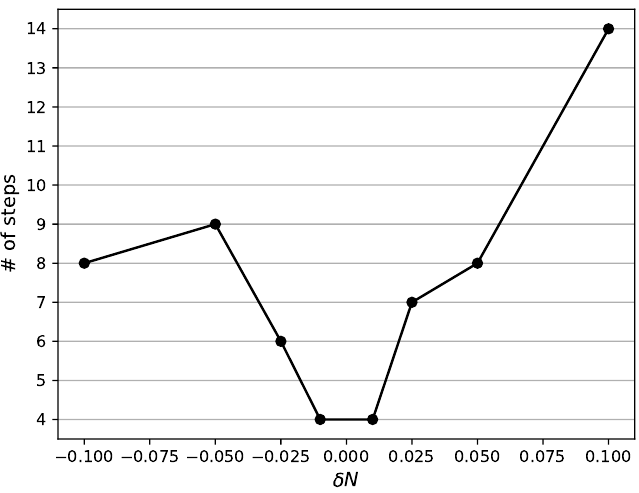
Figure 3: Number of function calls until BFGS terminates, for the step sizes consid- ered in Figure 2 with initial point given by eq.